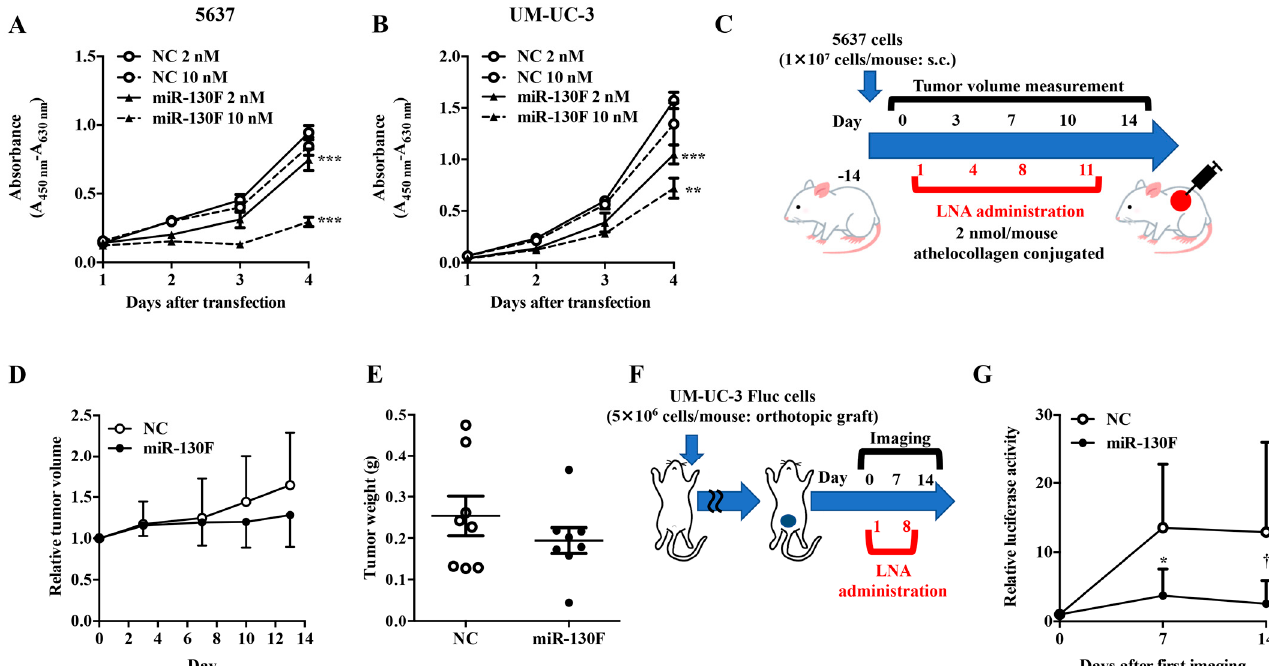
Figure 1. Functional verification of miR-130 family targeted LNAs in bladder cancer cells. The effect of miR-130 family targeted LNA (miR-130F) on the proliferation of 5637 ( A ) or UM-UC-3 ( B ) cells was measured using a WST-8 assay. Data are presented as the mean ± SD ( n = 4). Data were analyzed using one-way ANOVA with Bonferroni post-hoc tests ** p < 0.01, *** p < 0.001. ( C ) Evaluation scheme of miR-130 family targeted LNA (miR-130F) in a 5637 cell-xenograft model. Control LNA (NC) and miR-130F conjugated with athelocollagen were administered at a dose of 2 nmol/mouse into 5637 cell-xenograft mice. ( D ) Relative tumor volume was calculated using the formula: tumor volume [mm 3 ] = (major axis [mm]) × (minor axis [mm]) 2 × 0.5. Tumors resected on day 14 were weighed ( E ). Data are presented as the mean ± SD ( n = 8). ( F ) Evaluation scheme of miR-130 family targeted LNA (miR-130F) in an orthotopic bladder cancer model. ( G ) Control LNA (NC) and miR-130F were transurethrally administered at a dose of 4 nmol/mouse in UM-UC-3 cell-inoculated mice. Relative tumor volume was measured by in vivo imaging. Data are presented as the mean ± SD ( n = 5). Data were analyzed using the Mann–Whitney U test * p < 0.05; † p = 0.05.